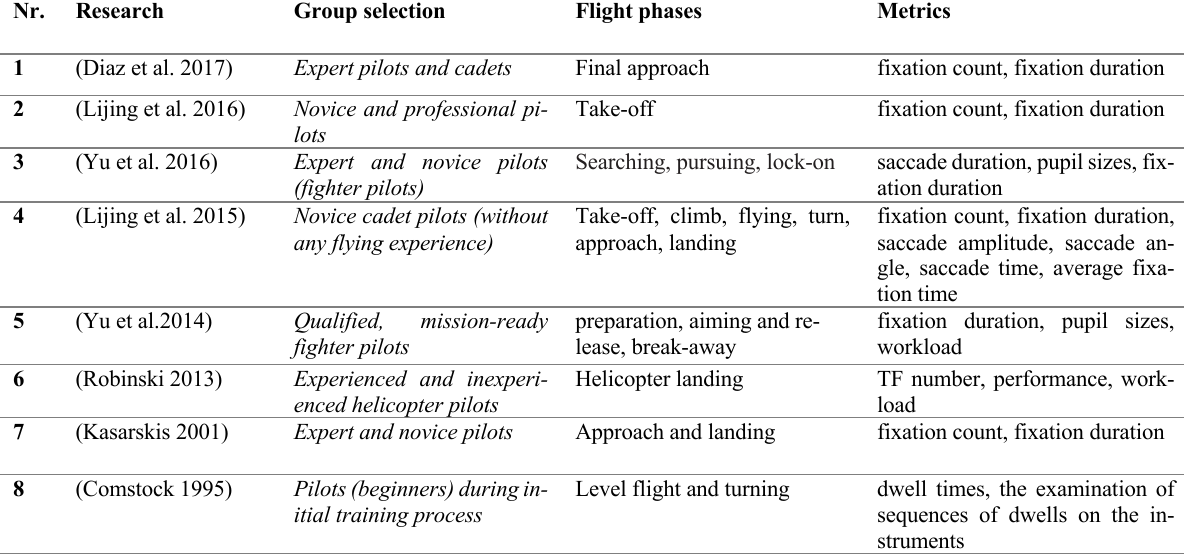
Eye movement studies in Flight